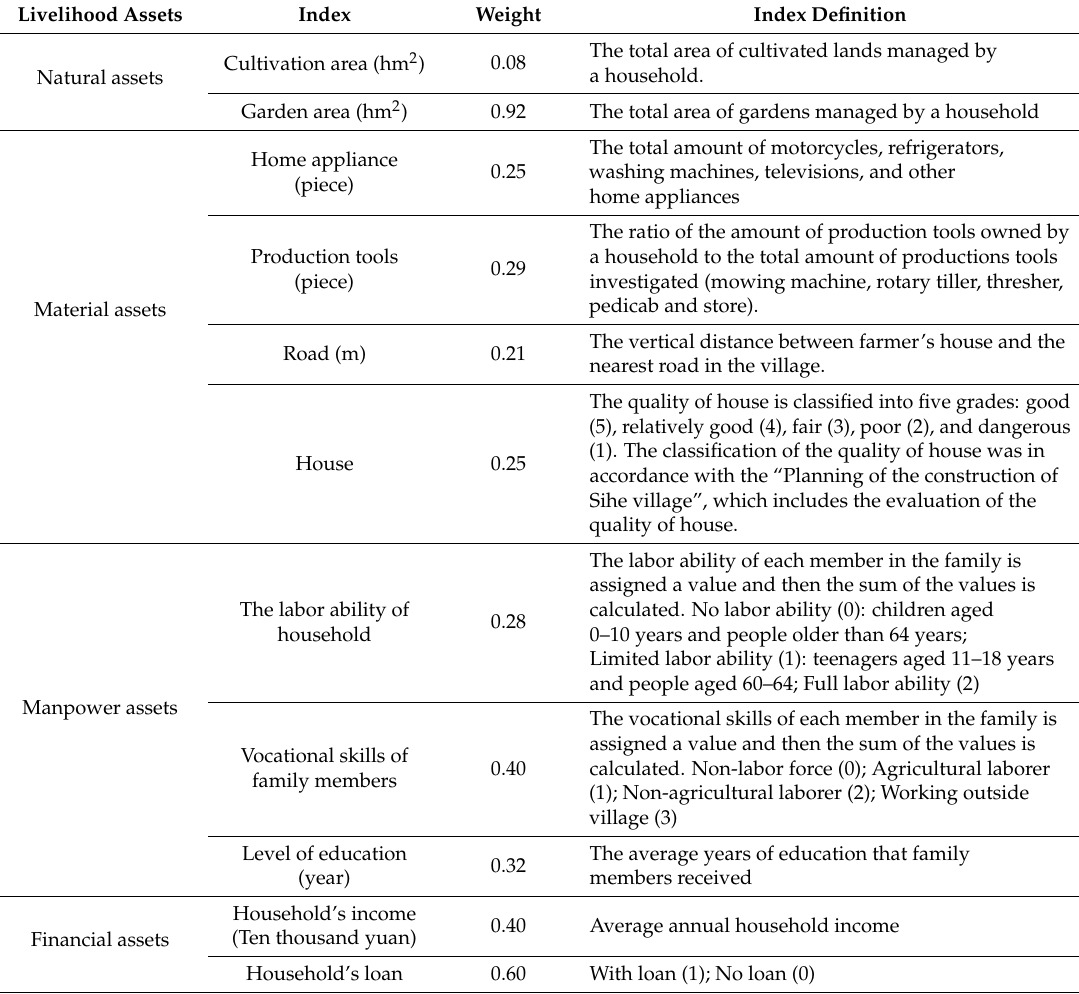
Table 2. Index system for quantification of livelihood